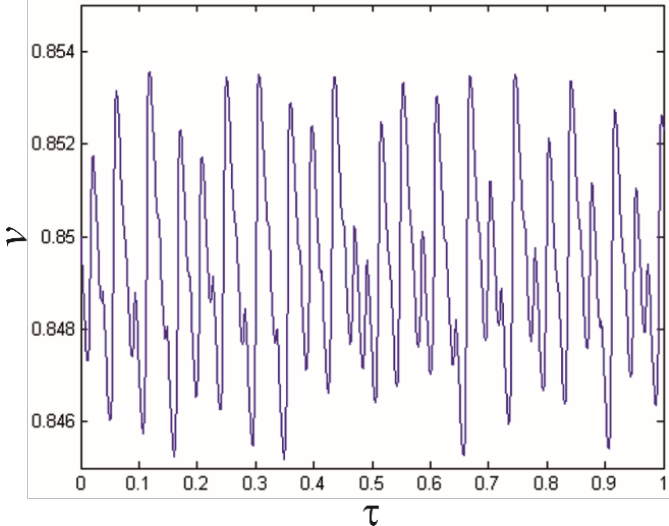
Figure 3. The evolution of the v ( τ ) concentration at low flux (α = 6000/9; β = 8/23; A = 0.1 mol; C = 8.33 × 10 −4 mol; M = 0.25 mol; H = 0.26 mol and k f = 3.9 × 10 −4 ) and initial values: x (0) = 0.045, z (0) = 0.9 and v (0) = 0.85.